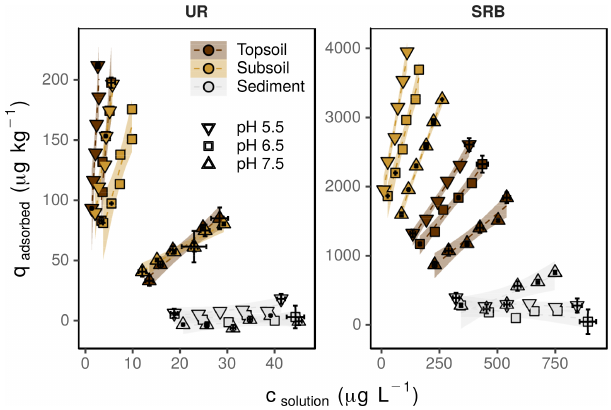
Figure 2. Sorption isotherms for UR and SRB determined at pH 5.5 (down-pointing triangle), 6.5 (square) and 7.5 (up-pointing trian- gle) in topsoil (brown), subsoil (yellow) and sediment (grey). The error bars represent the standard deviation of the tracer concentra- tion measured in solution ( c solution ) and the calculated content of the adsorbed tracer ( q adsorbed ) ( n = 3). Note the different concen- tration ranges of UR and SRB. The transparent areas around the regression lines represent the 95%-confidence intervals.